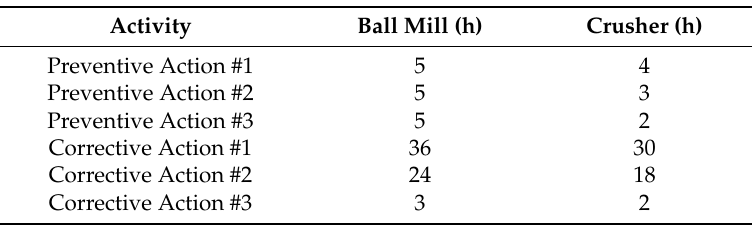
Table 1. Activity list and its duration.